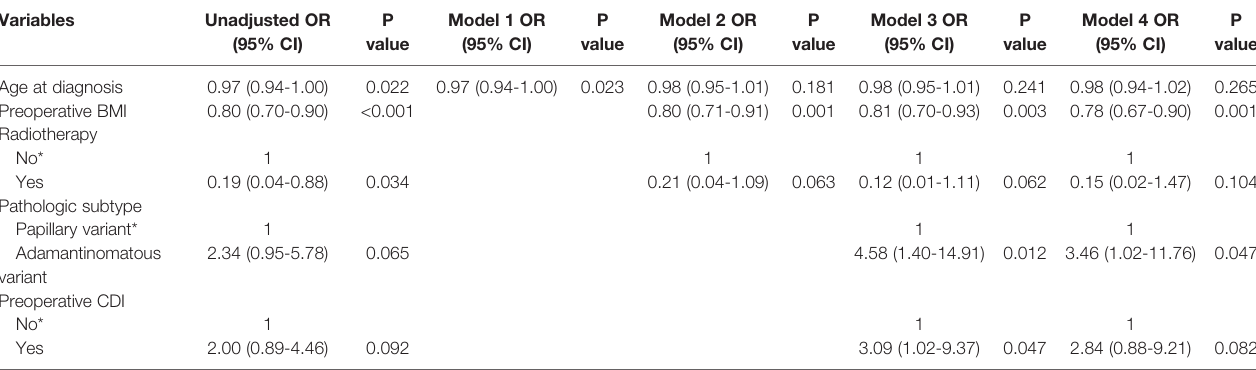
Model 1: age at diagnosis, gender, follow-up time. Model 2: Model 1 + preoperative BMI, Radiotherapy. Model 3: Model 2 + pathologic subtype, preoperative CDI. Model 4: Model 3 + preoperative hypothalamus involvement. *Reference.